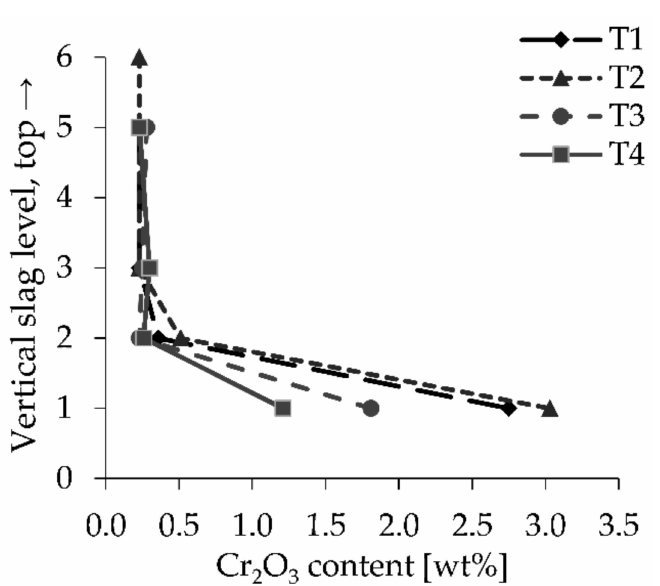
Figure 7. Chromium oxide content at the vertical slag levels in batch T1–T4 at the settling